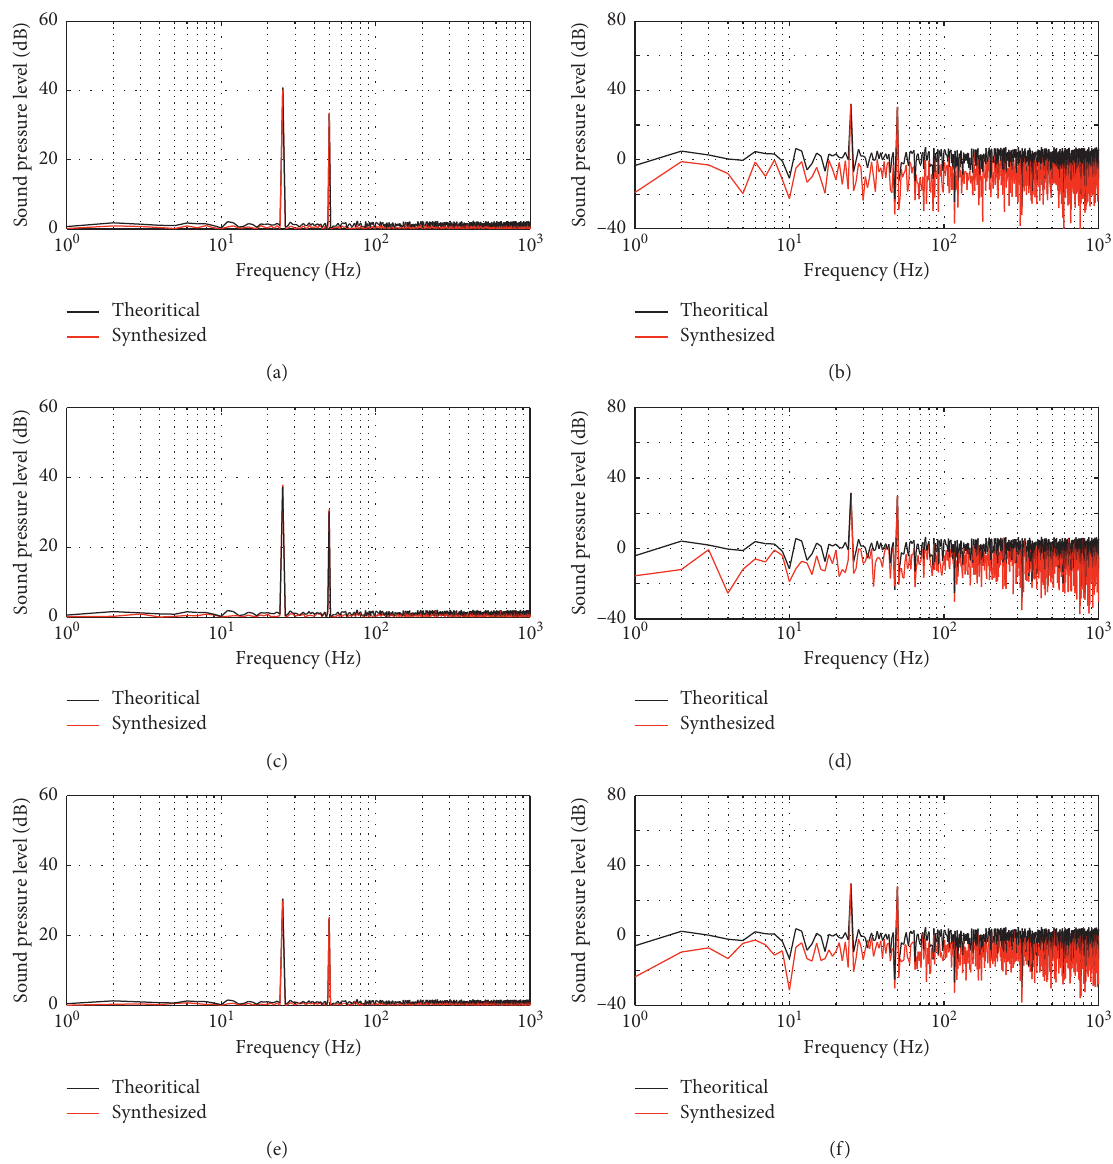
Figure 25: Sound pressure level spectrum and response synthesis in function of the distance: (a) d � 240mm; (b) d � 240mm; (c) d � 750mm; (d) d � 750mm; (e) d � 1400mm; (f) d � 1400mm.